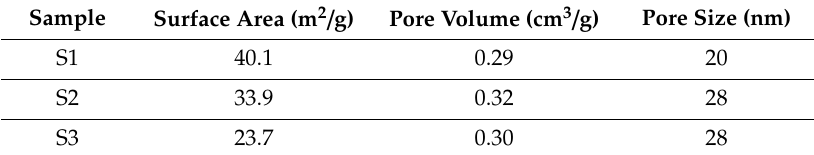
Figure 2. N 2 adsorption–desorption isotherms for the three prepared samples. The scale in the y-axis corresponds to the S1 sample while, for clarity purposes, the S2 and S3 isotherms are scaled up by 100 cm 3 / g and 200 cm 3 / g, respectively. The inset shows the pore size distributions for the three samples. Table 1. N 2 -isotherm-generated textural properties of prepared